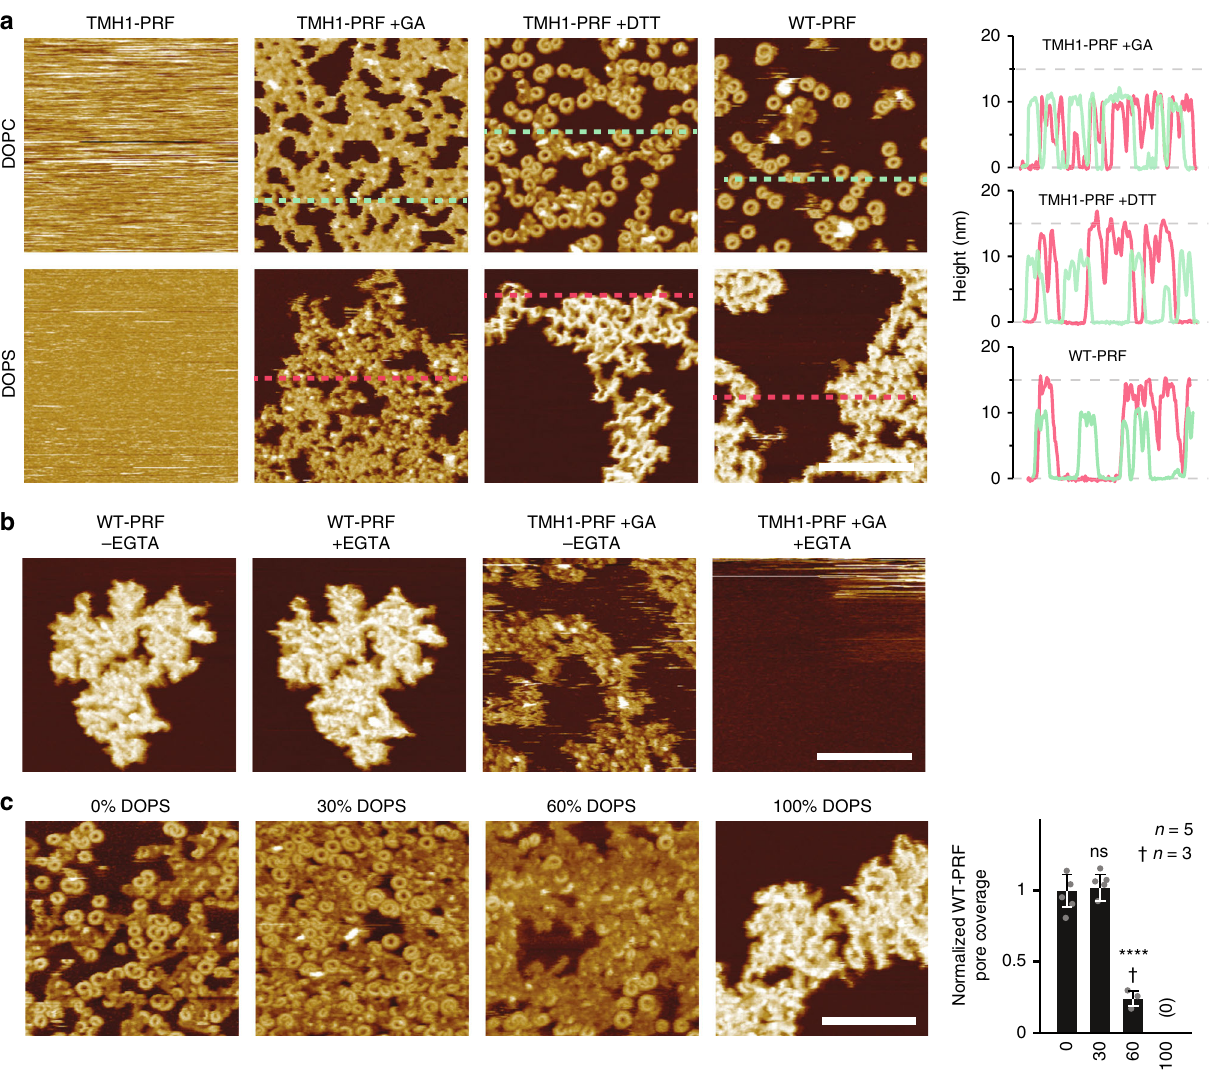
Fig. 5 Perforin forms non-porating clusters on phosphatidylserine membranes. a AFM images of DOPC and DOPS supported lipid bilayers after incubation with TMH1-PRF without or with glutaraldehyde ( + GA) fi xation, with unlocked ( + DTT) TMH1-PRF, or with WT-PRF. Height pro fi les were plotted as acquired along the dashed lines in the AFM image. On DOPC, prepore locked TMH1-PRF, and TMH1-PRF + DTT and WT-PRF assemblies all extend 10 – 11 nm above the membrane surface, in agreement with previous observations 5,6,19 . On DOPS, fi xed (and locked) TMH1-PRF assemblies have the same height, but the clusters of unlocked TMH1-PRF ( + DTT) and WT-PRF are distinctly taller, about 15 nm above the membrane. b AFM images of DOPS supported lipid bilayers incubated with WT-PRF or TMH-PRF + GA, before and after Ca 2 + chelation by washing the membrane with 5 mM EGTA (±EGTA). Clusters formed by WT-PRF are not removed or visibly affected by washing the membrane with EGTA. In contrast, cross-linked plaques of TMH1-PRF + GA are removed after the EGTA wash. This is consistent with failure of TMH1-PRF to insert into the membrane 6 and suggests that WT-PRF partially inserts into the DOPS membrane. All samples were incubated at 37 °C and imaged at room temperature. Colour (height) scale for all panels as in Fig. 3b. c AFM images of supported DOPC bilayers mixed with 0 – 100% DOPS, after incubation with 150 nM WT-PRF. The images show decreased formation of arc- and ring-shaped perforin pores upon increased DOPS content, and an increased amount of clustering. Bar graph on the right shows quanti fi cation (see Methods; mean ± standard deviation) of pore formation on DOPS containing membranes: for 60% DOPS, there is a signi fi cant decrease in the number of pores, and at 100% DOPS there are no unambiguous pore features found. Statistical signi fi cance was assessed using ANOVA with Dunnett ’ s post-hoc analysis, where ‘ ns ’– not signi fi cant, **** p < 0.001. Scale bars, 200